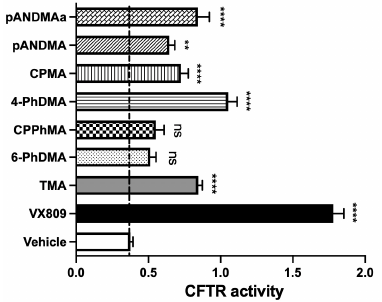
Figure 4. Evaluation of different TMA analogs as F508del CFTR correctors in CFBE41o- YFP-F508del cells. Correction of F508del-CFTR function was assessed, in a single cell, by measuring the decrease in YFP fluorescence upon addition of extracellular iodide and with the activating cocktail, in the presence or absence of CFTR inhibitor, CFTRInh-172. Iodide influx was tested under control condition (vehicle) or after 48 h incubation with the correctors 200 nM or 1 µ M VX809. The YFP fluorescence decay rate was calculated by fitting the fluorescence data with an exponential function of time courses. presence and absence of CFTRInh-172. Fluorescence coming from every single cell of at least five cells per field was recorded. Each bar corresponds to the mean ± SEM of data points coming from at least three different experiments (5–10 different cells/each experiment). Statistical comparisons were made using a nonparametric Kruskall–Wallis test (** p < 0.01, and **** p < 0.0001, ns: not significant). pANDMAa = pANDMA mesylate